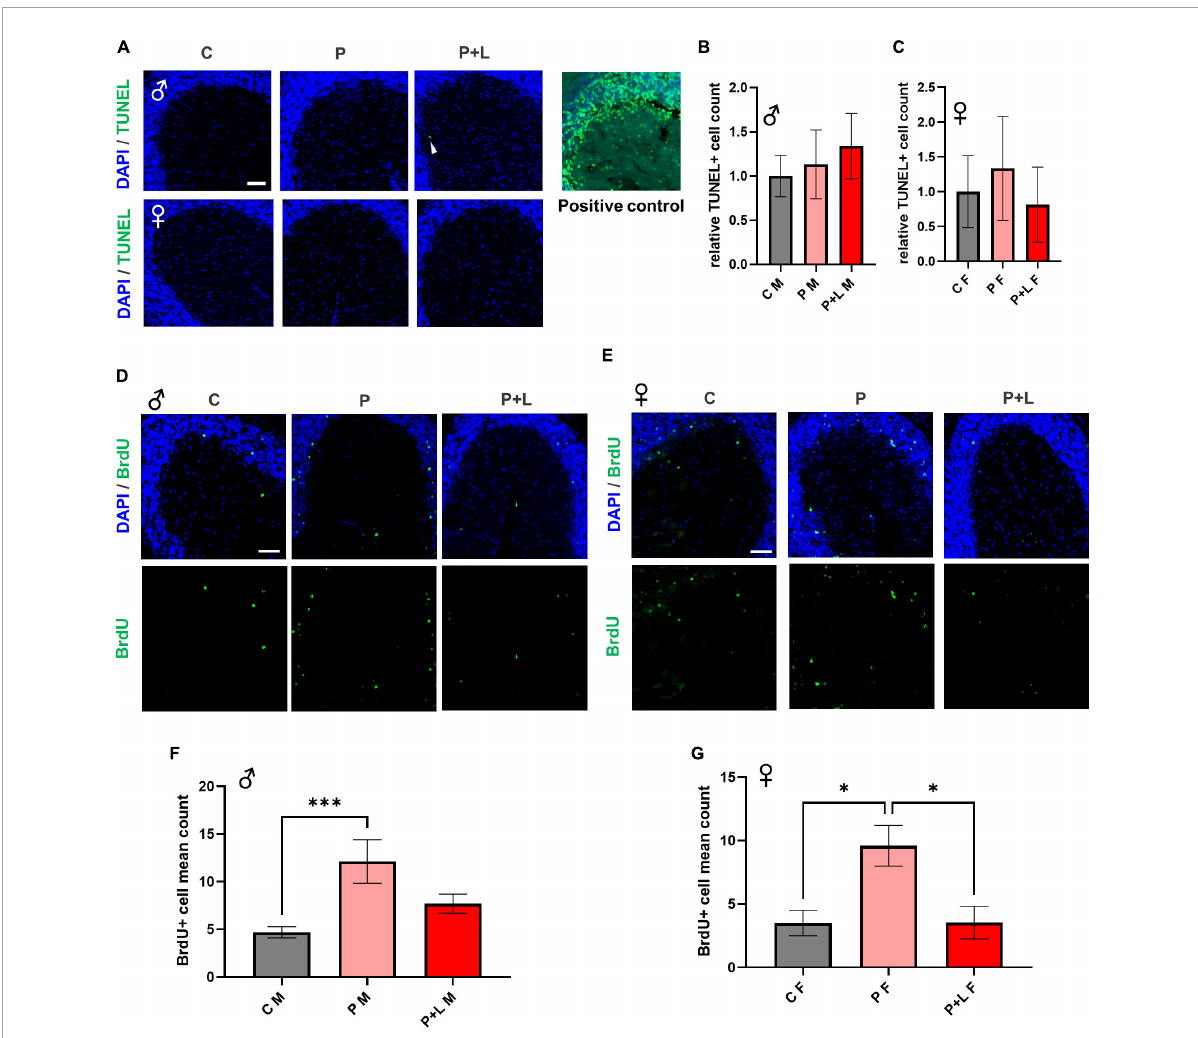
FIGURE3 Lead-induced cellular alteration in offspring mouse cerebellum. (A) Representative images of TUNEL assay. Male (upper) , female (lower) . Scale bars, 50 µ m. Positive control (DNase I) (B,C) Statistic analysis of TUNEL+ count. Any significant change was not shown in TUNEL assay. N = 3 per group. Data are representative at least three independently performed experiments and analyzed with one-way ANOVA, expressed as mean ± SEM. (D,E) Immunofluorescence images of BrdU (green) to identify differentiated cells. Scale bars, 50 µ m. (F,G) Statistic analysis of BrdU+ count in cerebellum. Data are representative at least three independently performed experiments and analyzed with one-way ANOVA, expressed as mean ± SEM. (F) Result of BrdU immunostaining in male offspring. P group was significantly increased. N=3 per group, ∗∗∗ p < 0.001. (G) Result of BrdU immunostaining in female offspring. P group was significantly increased same as male offspring, but P + L was decreased compared to P group. N = 3 pergroups, ∗ p <